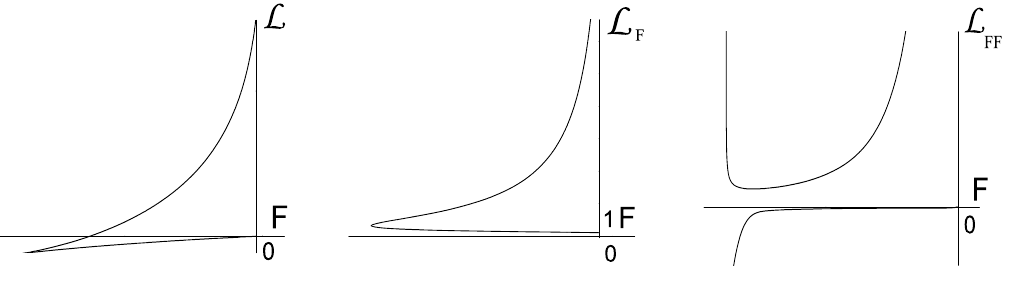
Figure 2. ( Left ): Typical behavior of the Lagrangian. ( Middle ): Behavior of the Lagrangian derivative L F . ( Right ): Characteristic behavior of the Lagrangian derivative